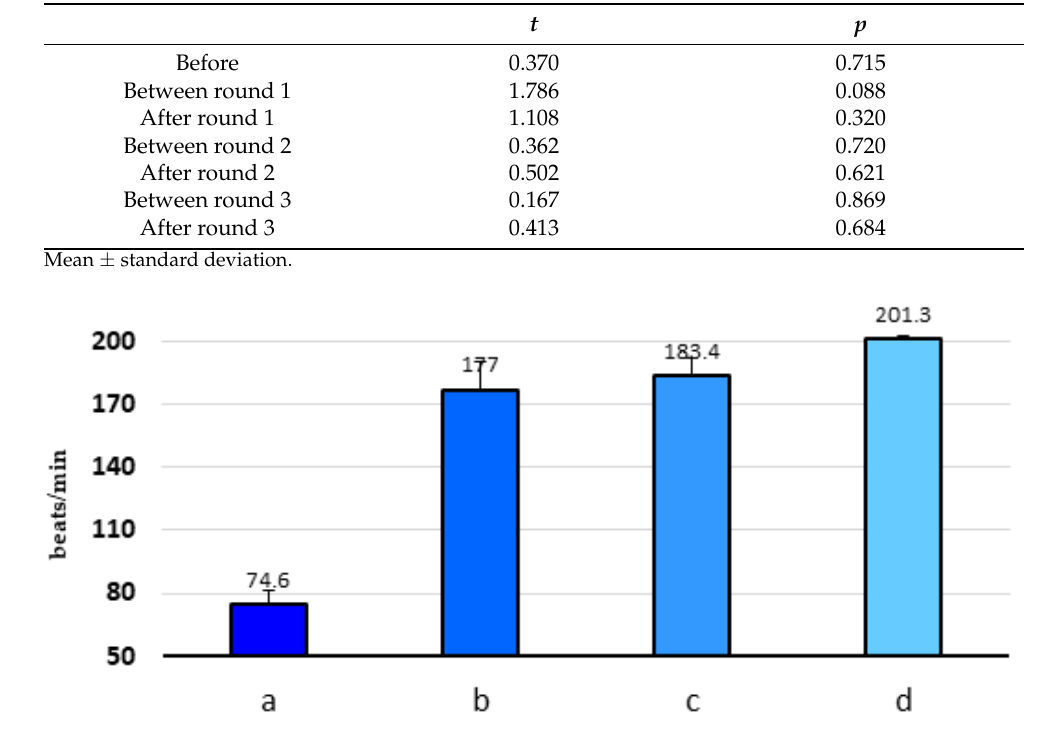
Table 1. Heart rate (HR) during a Taekwondo match.